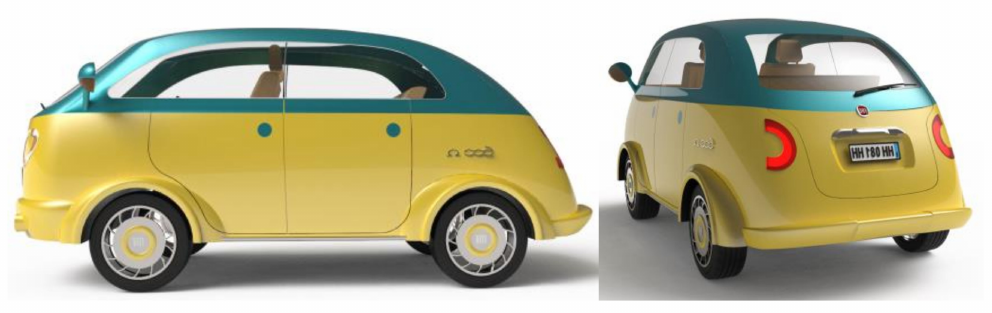
Figure 31. New FIAT 600 Omega—CAD 3D model and details: side and back rendering.